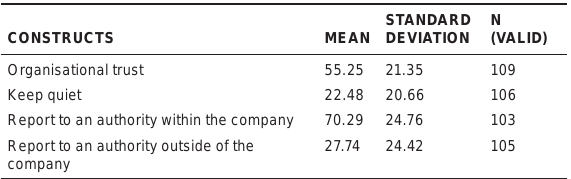
taBle 6 Organisational trust, internal whistleblowing and keep quiet